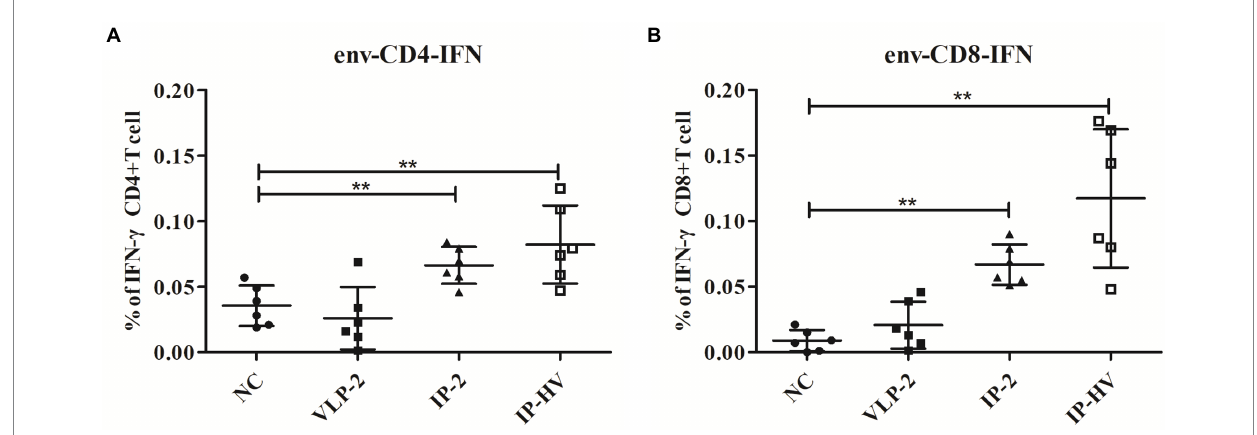
FIGURE 5 HIV-1 envelope-specific CD4 and CD8 T cell responses elicited by different immunization regimens. 56 days after the first injection, mice in different vaccination groups (VLP-2, IP-2, IP-HV and NC group) were humanly euthanized and spleens collected, T cell responses against HIV-1 envelop- specific peptides were analyzed by flow cytometry. The percentages of activated CD4 + (A) and CD8 + (B) T cells that produce IFN- γ were detected by intracellular cytokine staining. Mock-infected mouse served as the negative control (NC). * p < 0.05, ** p < 0.001.